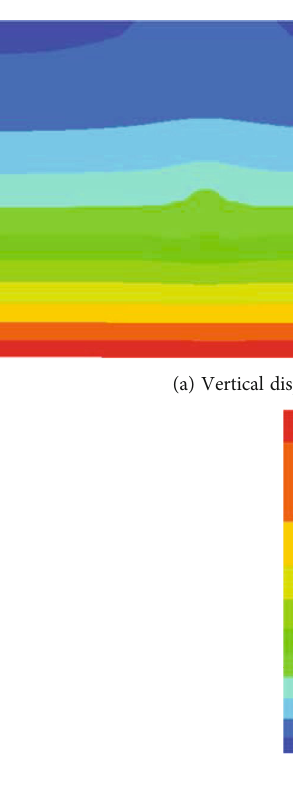
Figure 19: Initial horizontal displacement